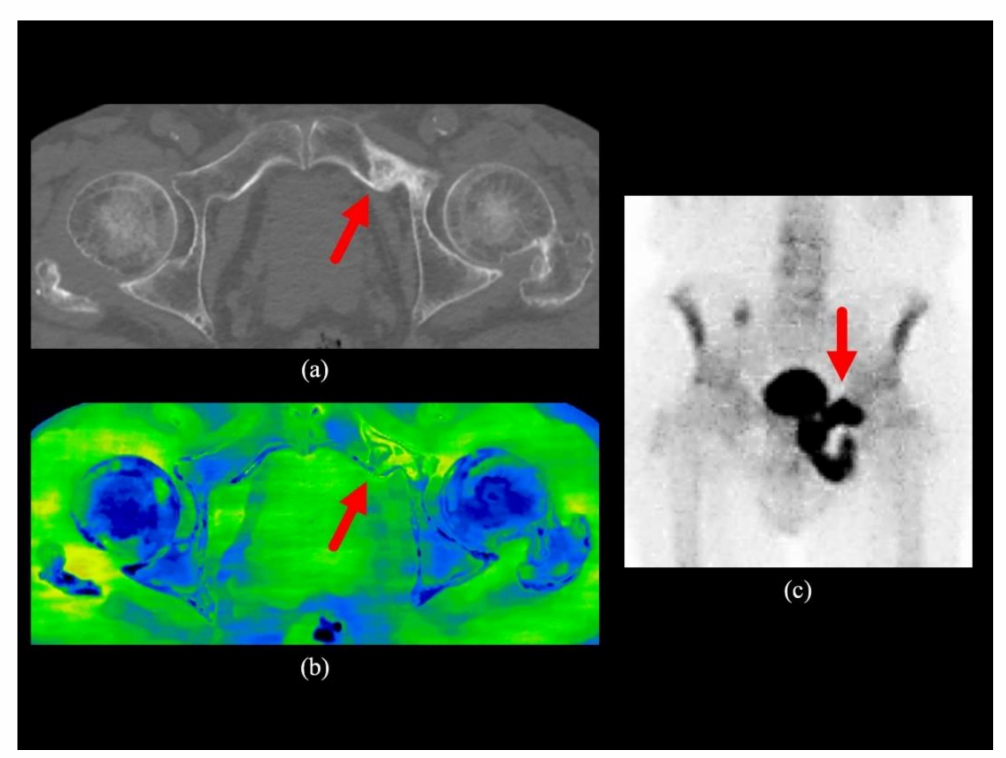
Figure 2. Clinical case 1. A man in his 80s with bone metastasis of prostate cancer. ( a ) The transaxial image of the conventional CT of the pelvis shows the sclerotic bone metastasis in the left superior pubic branch; ( b ) The transaxial water-HAP image of the pelvis shows a localised increase in water density compared to the other side (red arrow); ( c ) The anterior view of the bone scintigraphy shows increased uptake in the same region (red arrow). HAP;